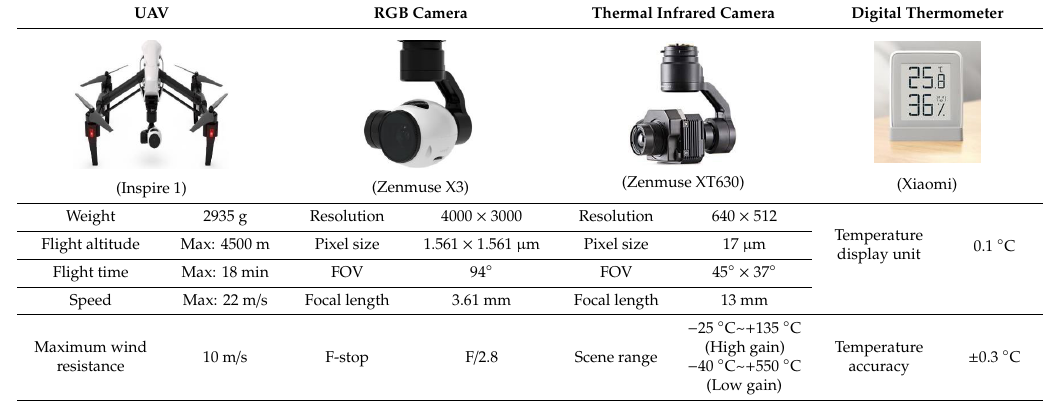
Table 1. Unmanned aerial vehicle (UAV), camera and digital thermometer specifications.